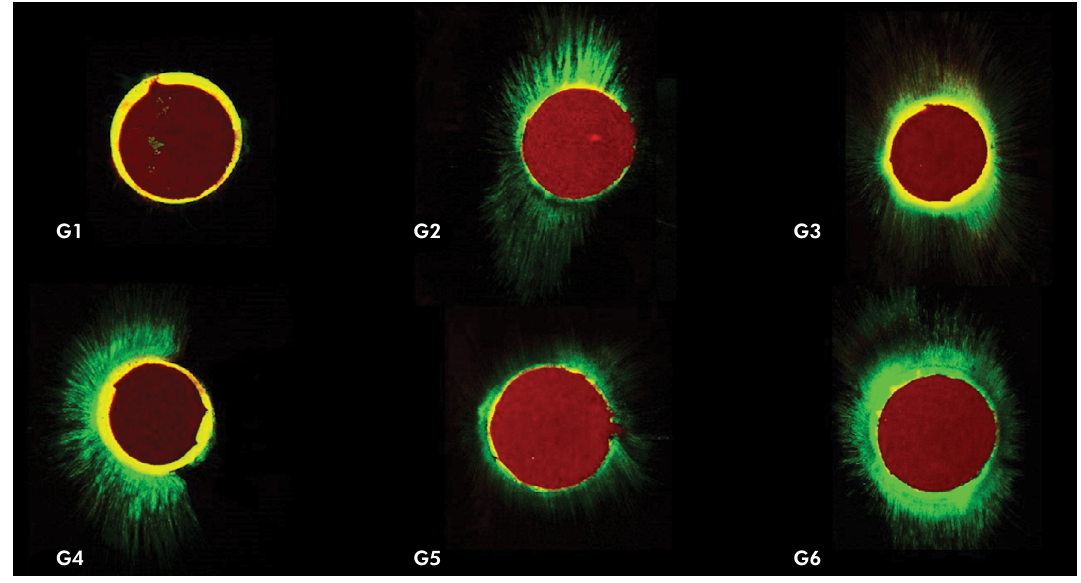
Figure 3. Demonstrative confocal laser scanning microscope images of each group (apical third), showing the cement penetration into root canal